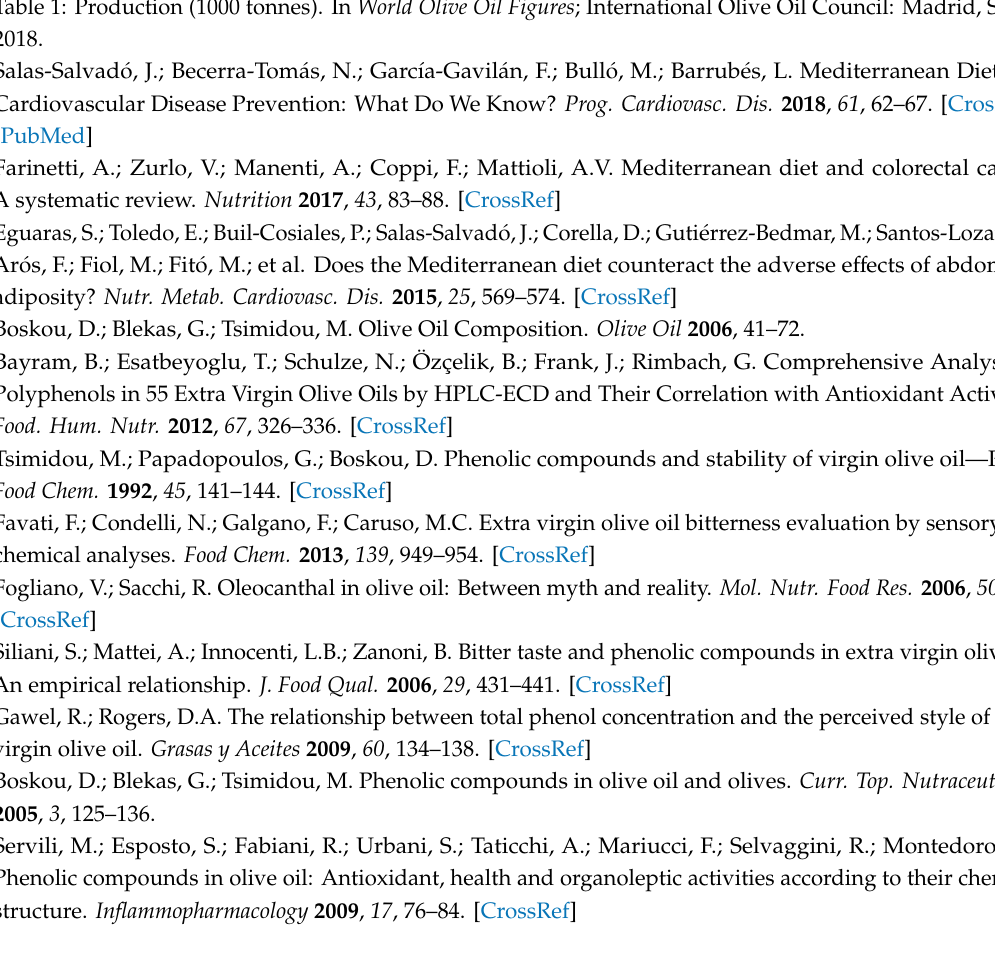
Table 1: Production (1000 tonnes). In World Olive Oil Figures ; International Olive Oil Council: Madrid,